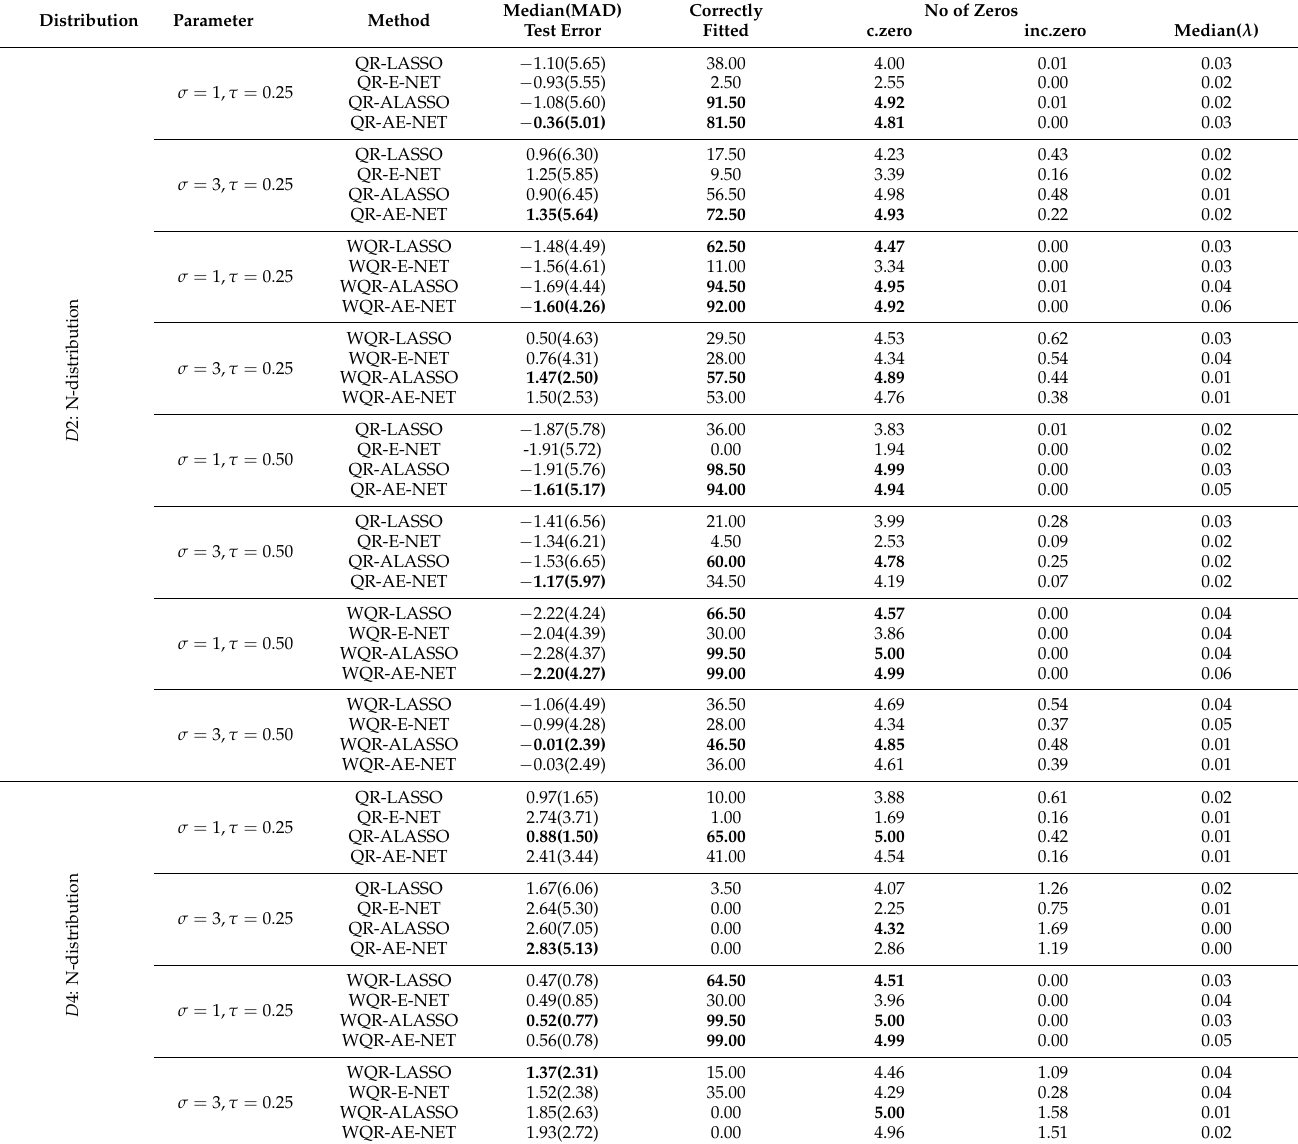
Table 2. Penalized weighted and unweighted quantile regression at D 2 and D 4 for n = 50 ( τ = 0.25 and τ = 0.50) under the normal distribution; bold text indicate superior